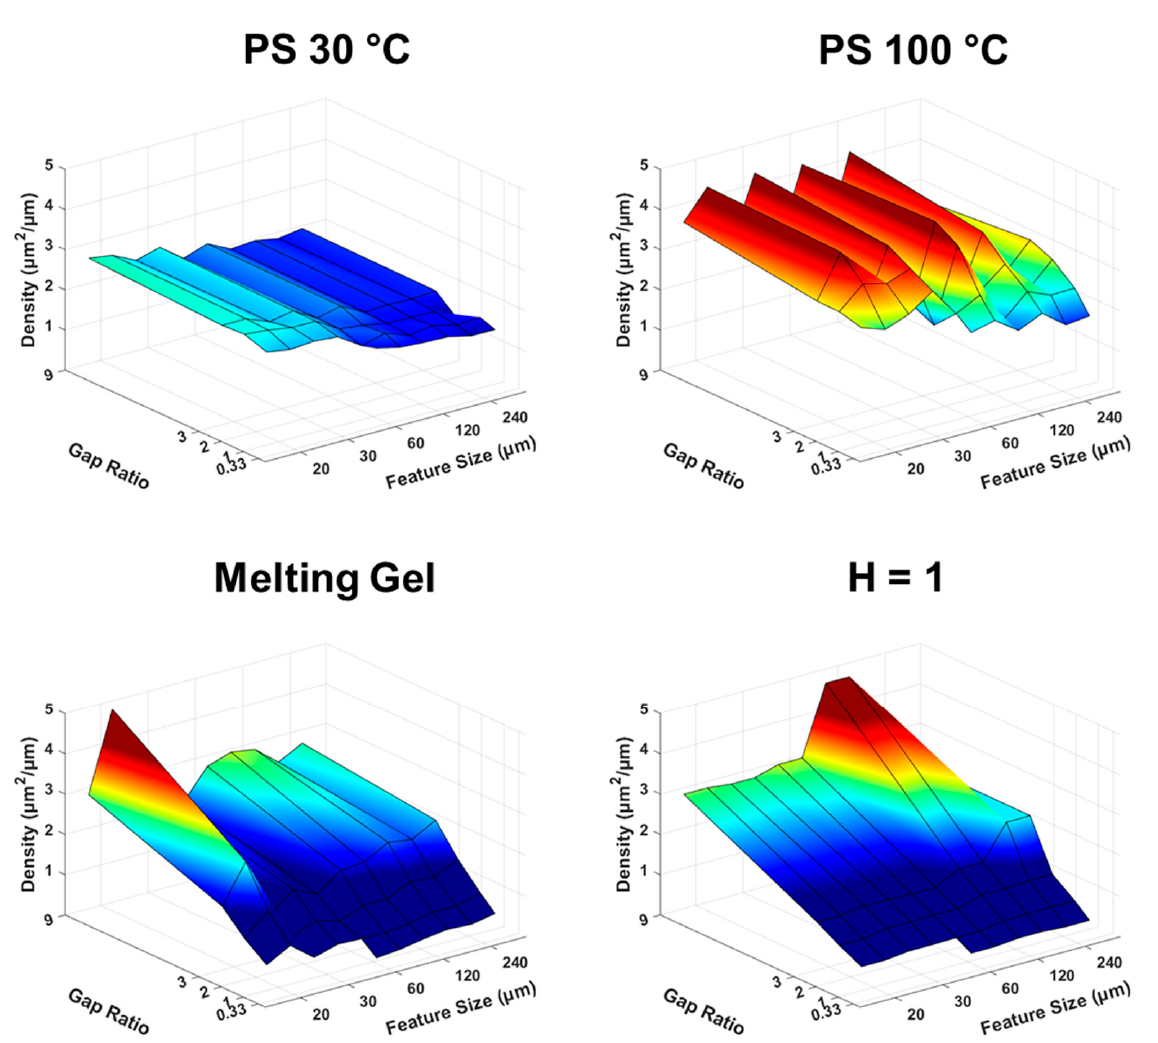
Figure 3. Surface maps of grating density plotted according to their gap ratio and feature size.